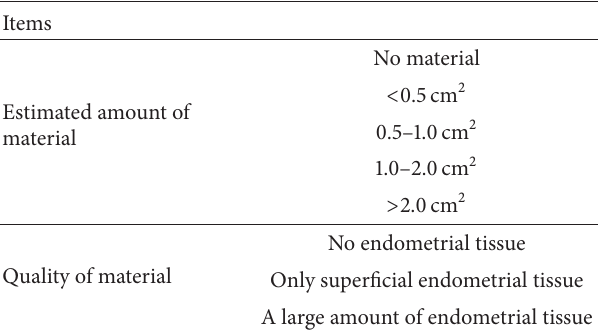
Table 1: Items for assessment of the adequacy of an endometrial biopsy